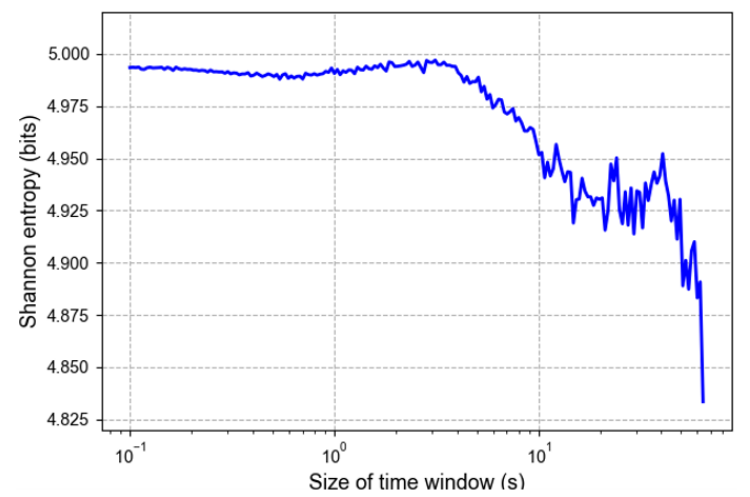
Figure 6. Entropy at di ff erent time window